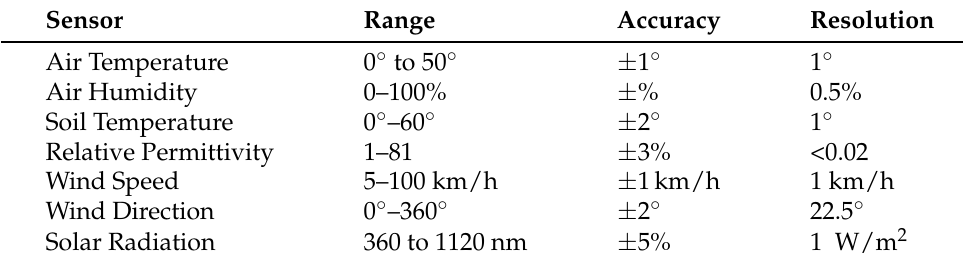
Table 1. Sensors’ technical specifications.